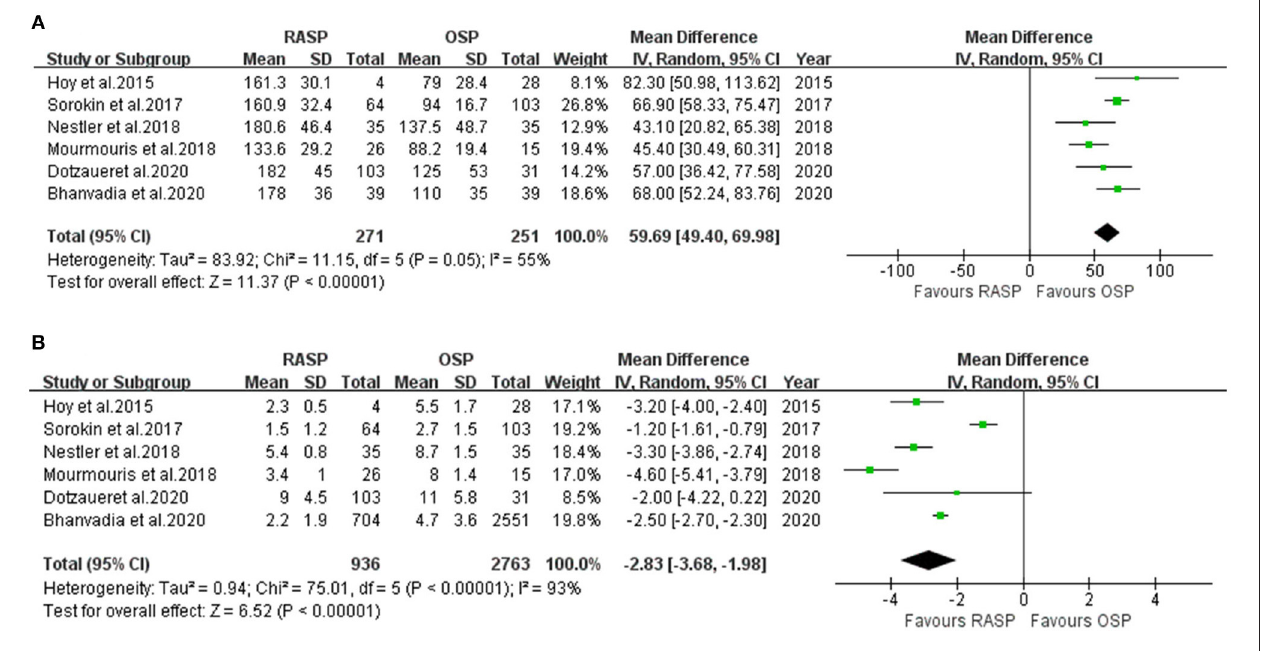
FIGURE 2 | Forest plot and meta-analysis of OT (A) and LOS (B)